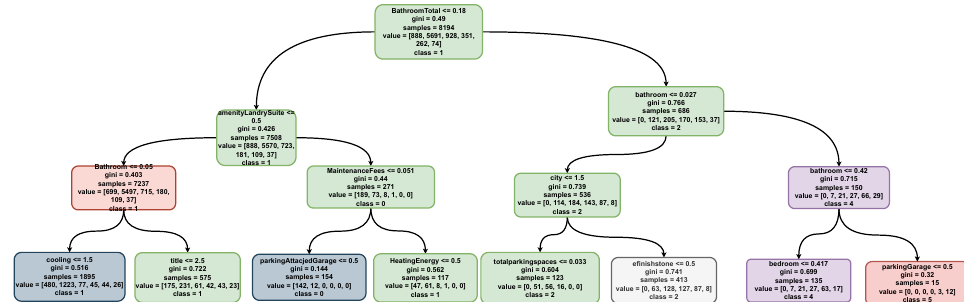
Figure 5. Graphical representation of a decision tree model built with a maximum depth of 4 to allow the interpretation of the